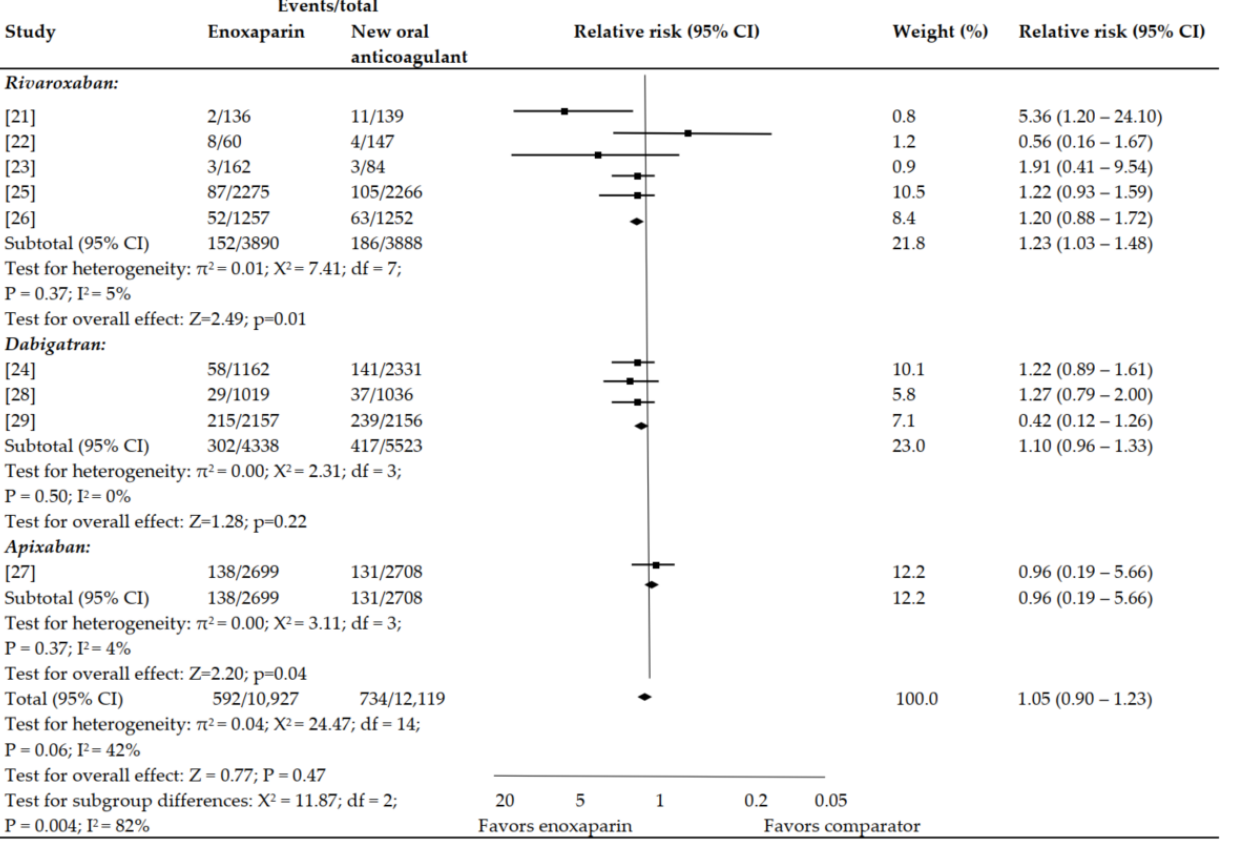
Figure 3. Clinically relevant bleeding.